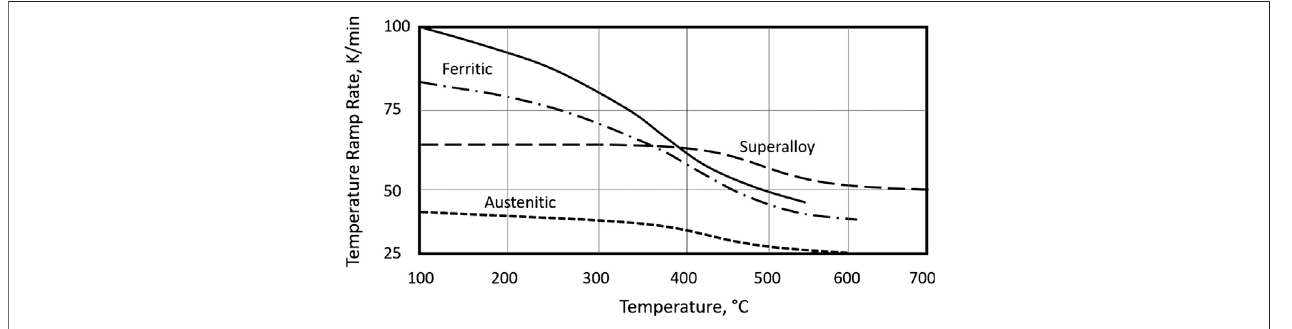
FIGURE 12 | Turbine rotor thermal ramp rates for different